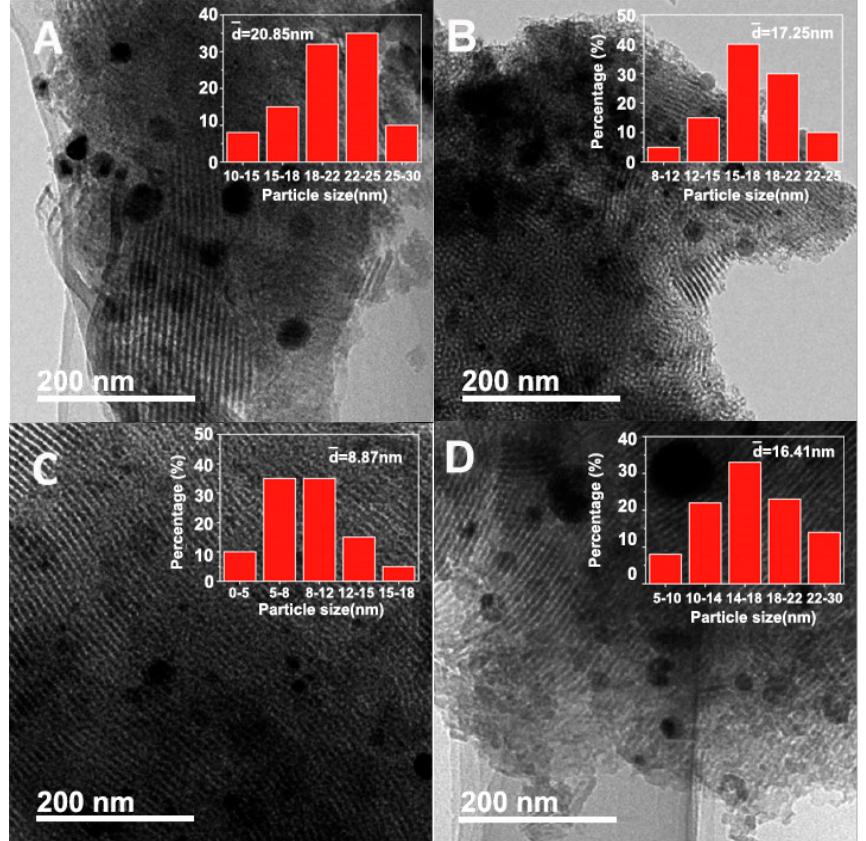
Figure 2. TEM (transmission electron microscopy) images of ( A ) Ni/SBA-15, ( B ) 5Ni-1Fe/SBA-15, ( C ) 5Ni-3Fe/SBA-15, and ( D ) 5Ni-5Fe/SBA-15 catalysts.